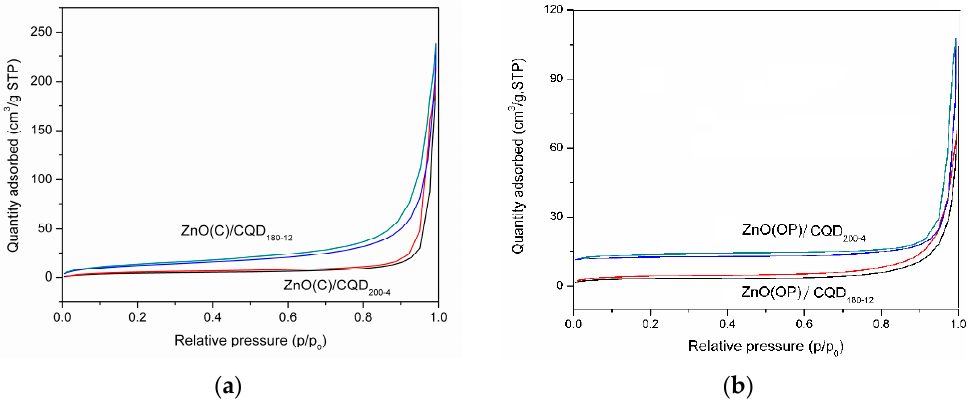
Figure 7. Nitrogen adsorption-desorption isotherms of the ZnO(C)/CQDs ( a ) and the Nitrogen adsorption-desorption isotherms of the ZnO(C)/CQDs ( a ) and the ZnO(OP)/CQDs ( b ) samples. ZnO(OP)/CQDs ( b ) samples.